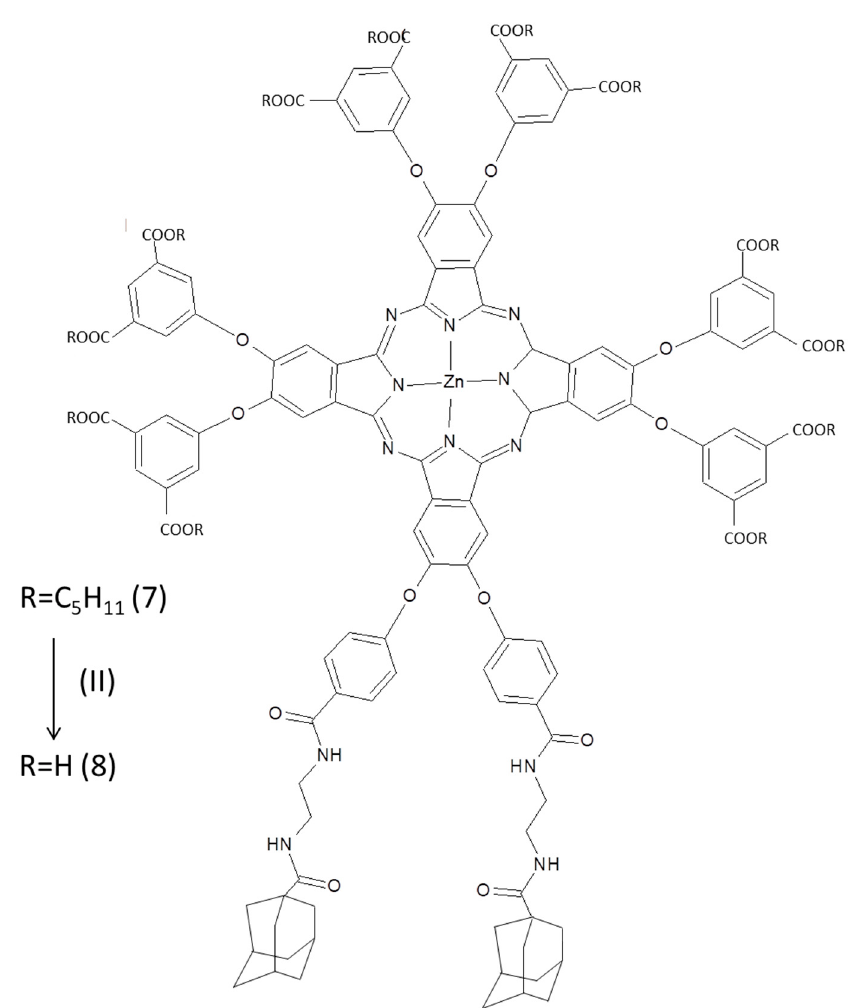
Figure 26. Octahoxosubstituted ZnPc bearing two adamantane groups [140].